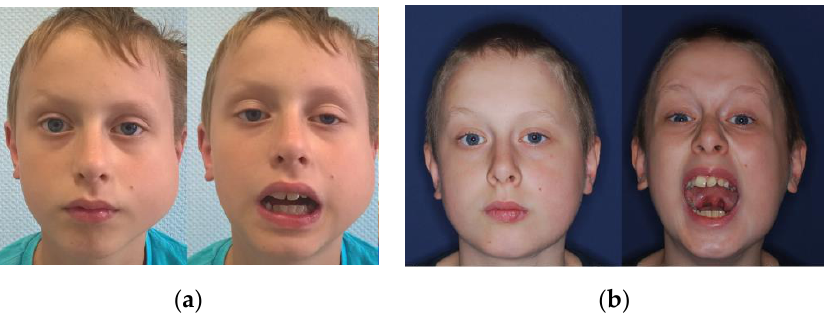
Figure 7. Photographs of an 8-year-old patient ( a ) before and ( b ) one year after the surgery, showing significant improvement in the range of mouth opening and satisfactory aesthetic results.